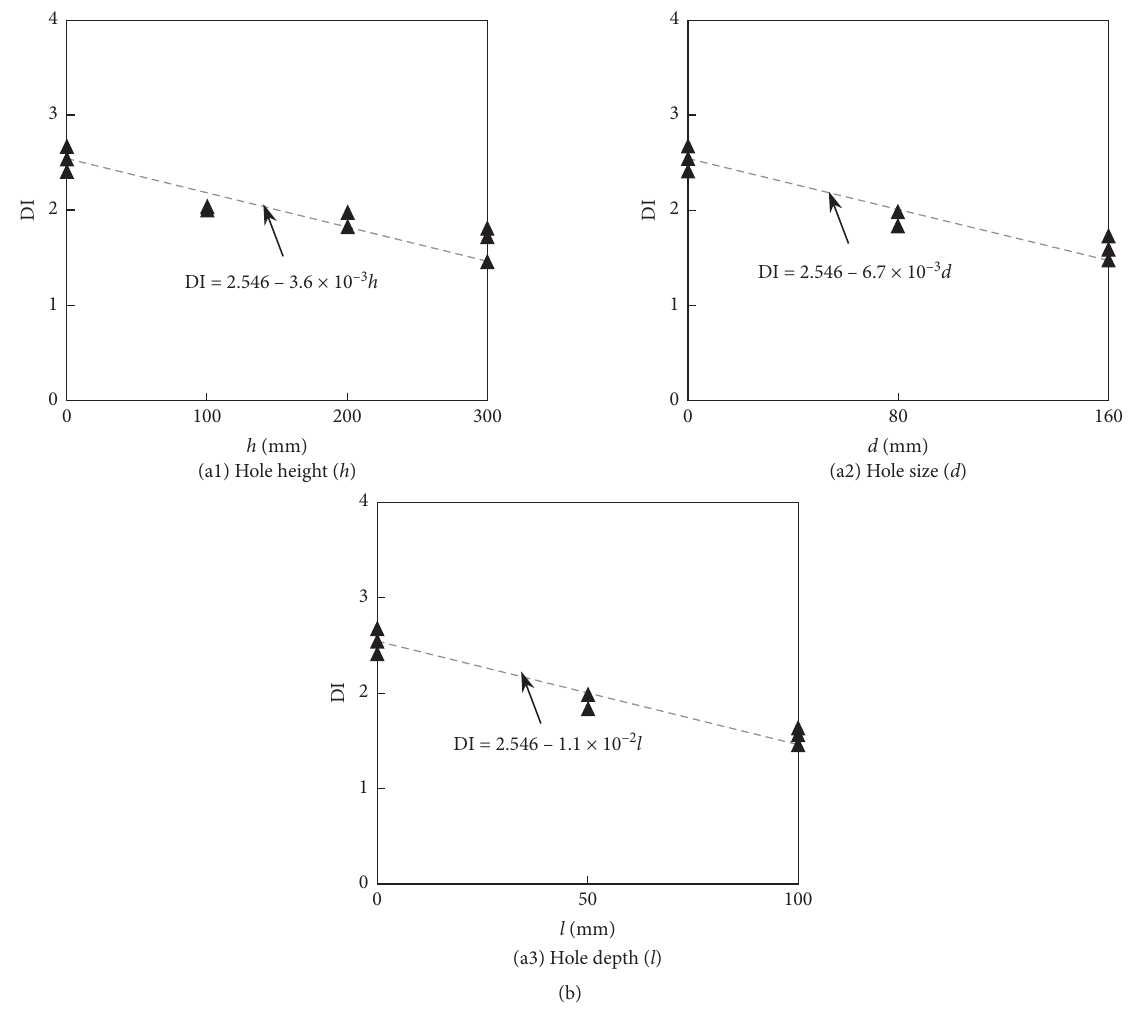
Figure 13: Ductility index (DI) versus different parameters relation. (a) Square section. (b) Circular section.